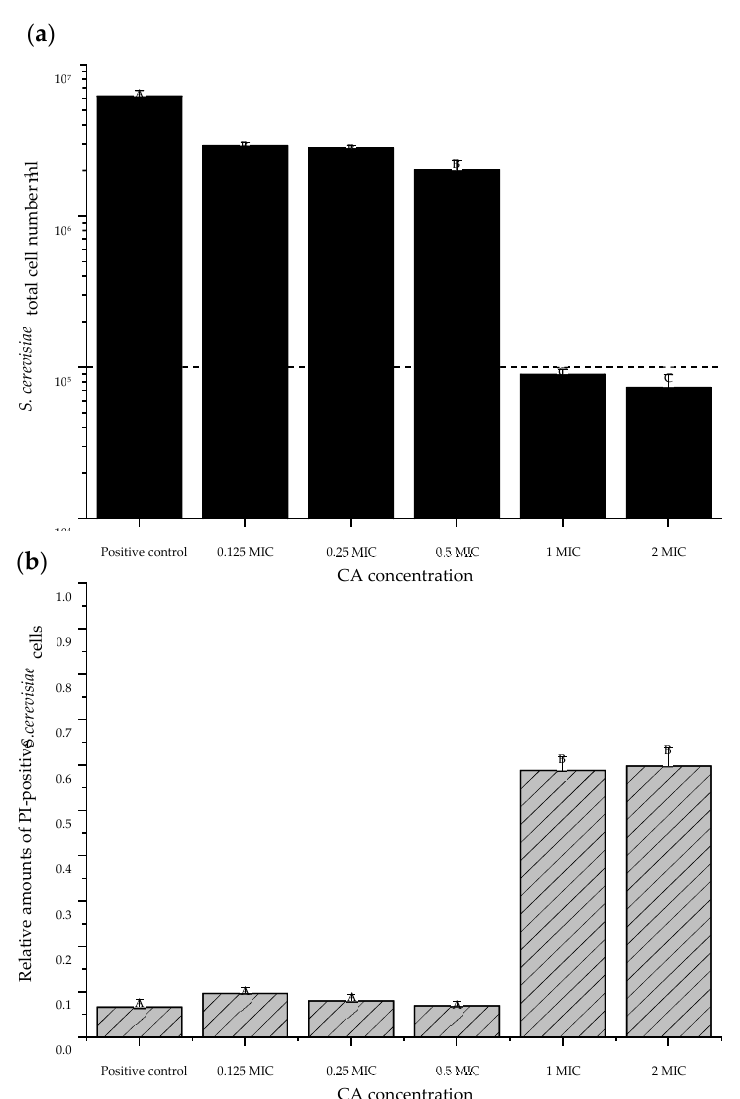
Figure 2. Total cell number ( a ) and relative amount of PI positive of S. cerevisiae cells ( b ) after 48 h of growth with cinnamaldehyde (CA). Positive control treated without CA; 0.125 minimal inhibitory concentration (MIC) CA (0.02 µL mL −1 ); 0.25 MIC CA (0.03 µL mL −1 ); 0.5 MIC (0.06 µL mL −1 ) CA; 1 MIC CA (0.125 µL mL −1 ); or 2 MIC CA (0.25 µL mL −1 ). Dashed line ( a ) denotes inoculum concentration. Error bars indicate standard error of six independent replicates ( n = 6). Different letters above bars indicate significant differences ( p < 0.05), according to one-way analysis of variance.